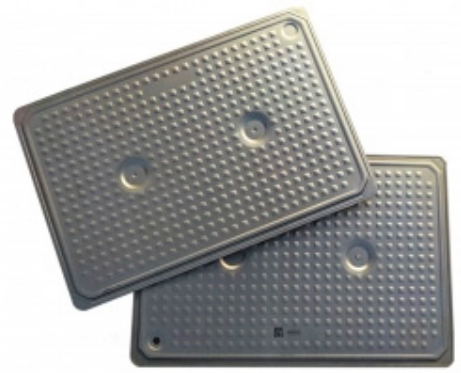
Figure 1. PCM encapsulated in aluminum container.